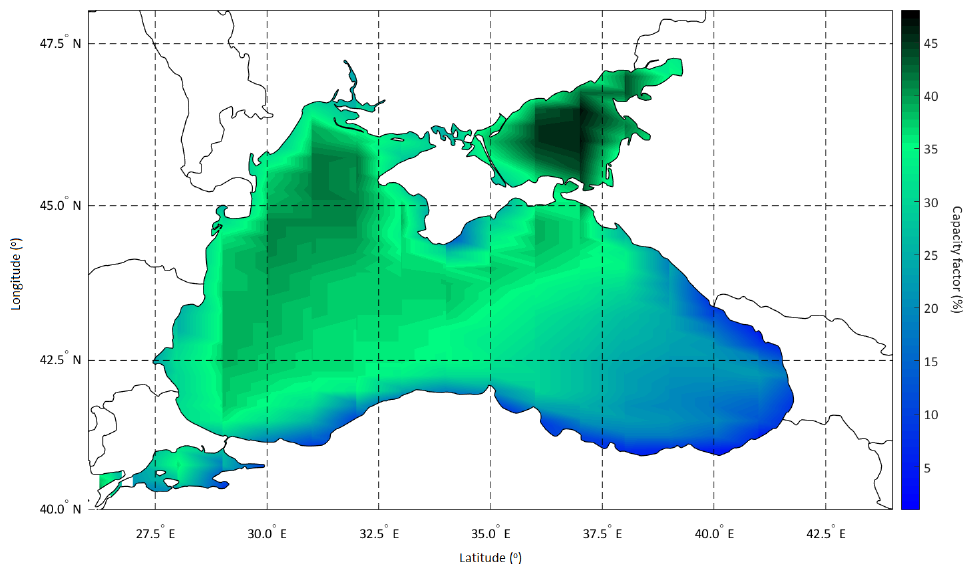
Figure 7. Wind turbine 5 MW—capacity factor (in %) related to the total time period. Results based on the U100 wind conditions.